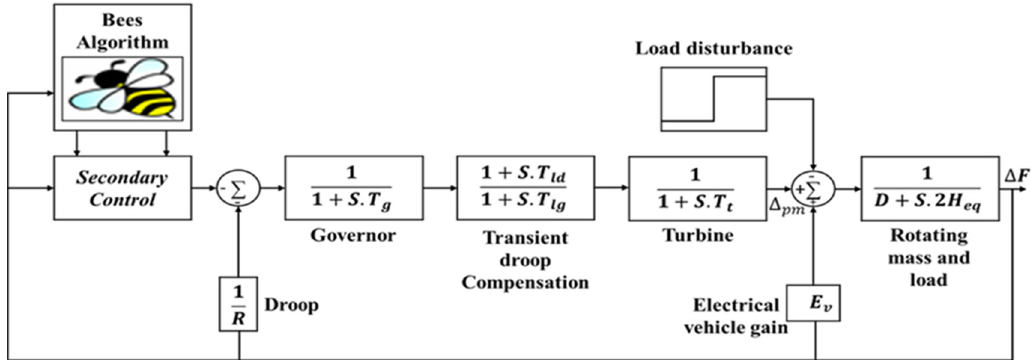
Figure 2. GB simplified power system.